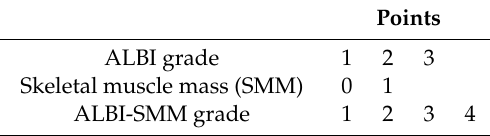
Table 1. Our proposed combined ALBI grade and skeletal muscle mass grading